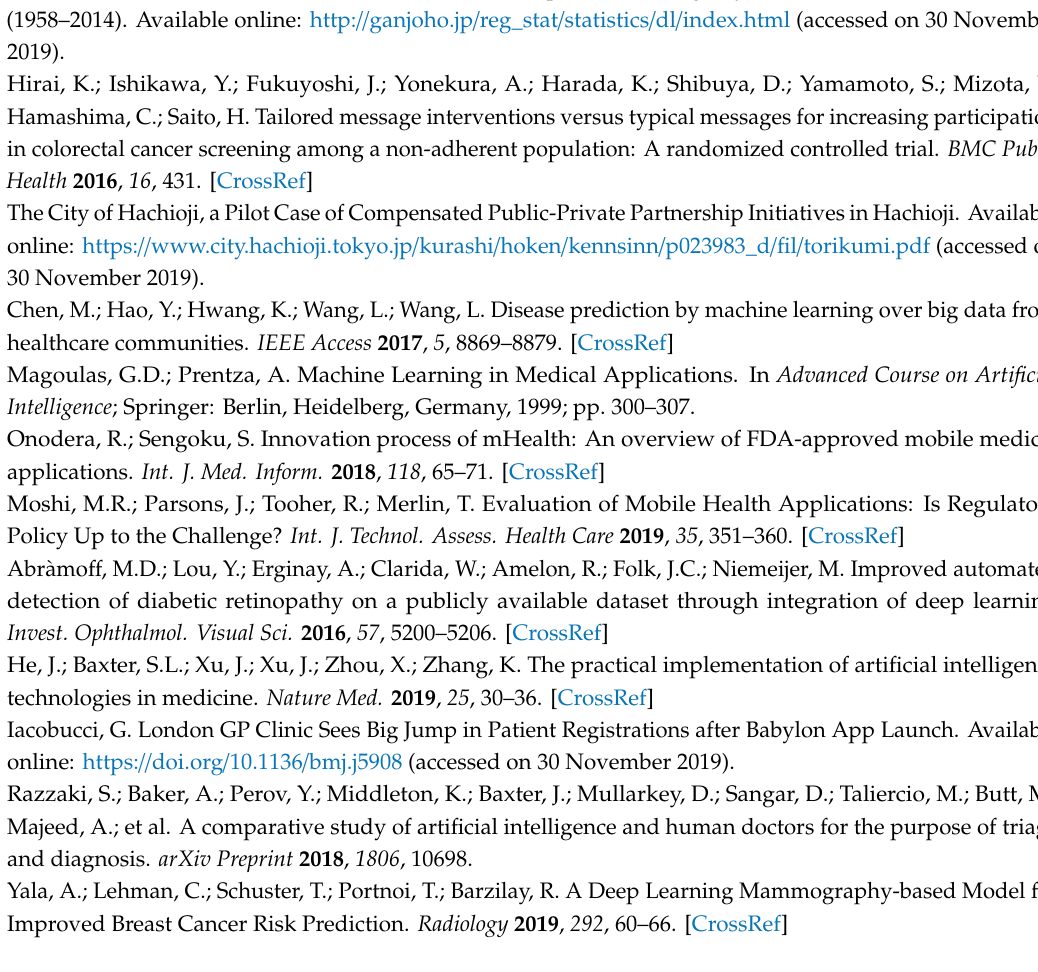
Figure S1: The original recommendation materials of Figure